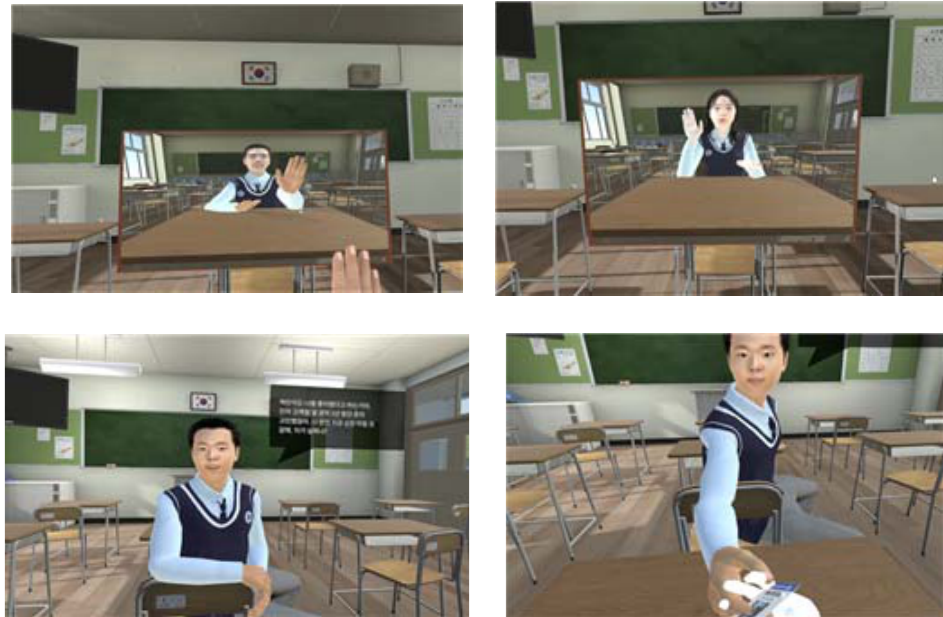
Figure 4. Sample views of the experiment stimulus from the user’s perspective: virtual mirror with male and female avatars ( top ); interaction with a virtual character who tells a story to the user ( bottom ).